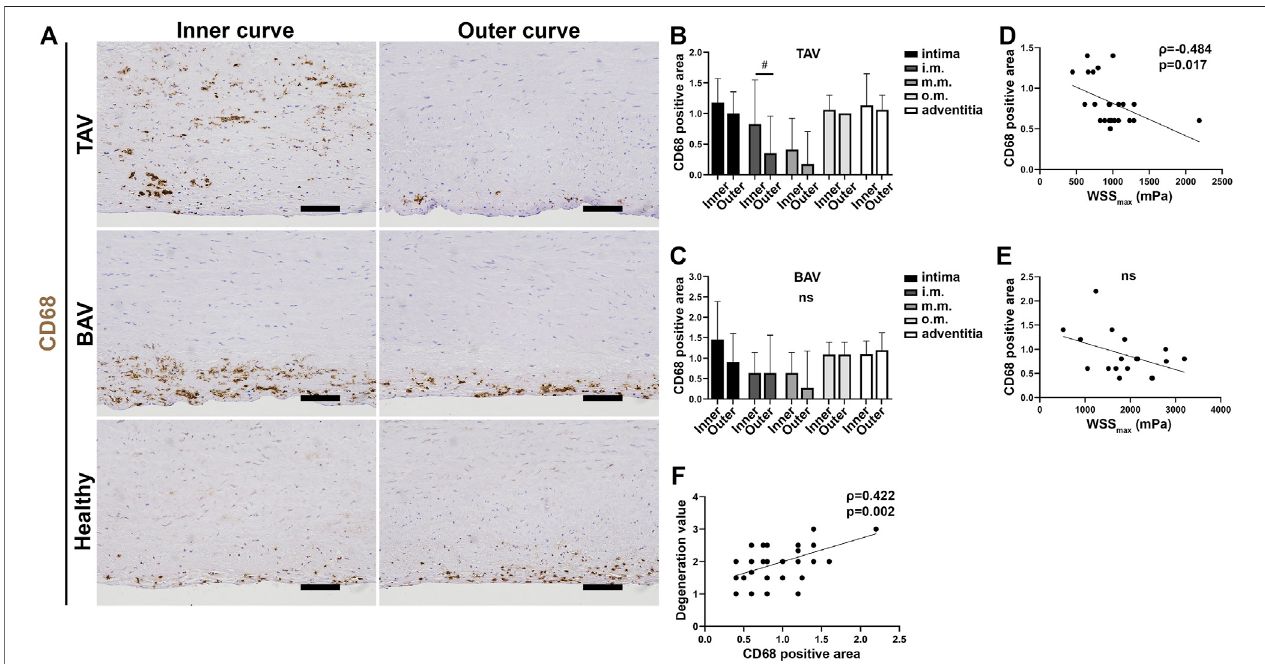
FIGURE 6 | (A) Representative images of CD68 + macrophages in patients with TAA. Scale bars, 100 µm. (B,C) CD68 + area scoring in TAV (B) and BAV (C) patients. In TAV patients, increase of macrophages was detected in the inner curves of the AA in the innermost part of the medial layer. (D,E) Correlation was detected between CD68 + area and maximum total WSS in TAV (D) but not with BAV (E) . (F) Correlation was detected with media degeneration score and CD68 + area in all patients with TAA. p -values < # 0.05, ns not signi fi cant. Non-parametric test.